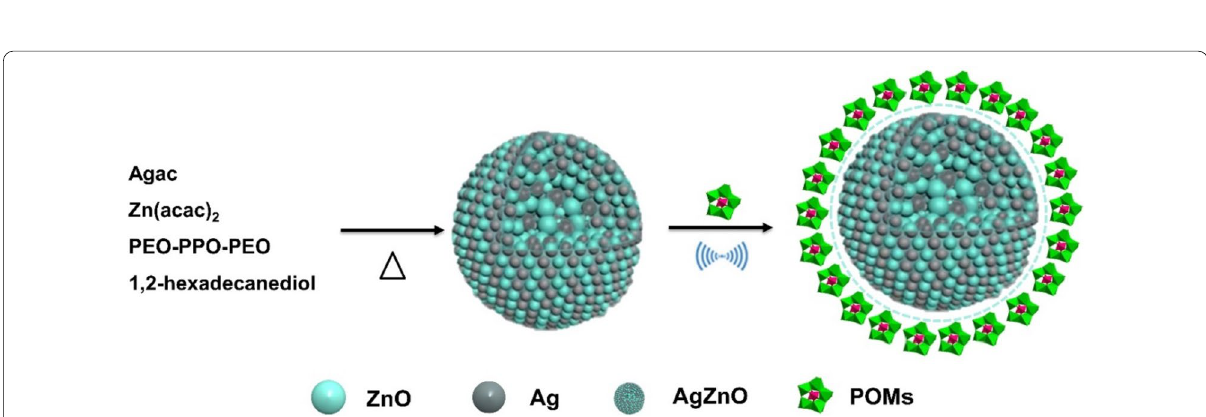
Scheme 1. Diagram of synthesis of the AgZnO/POMs